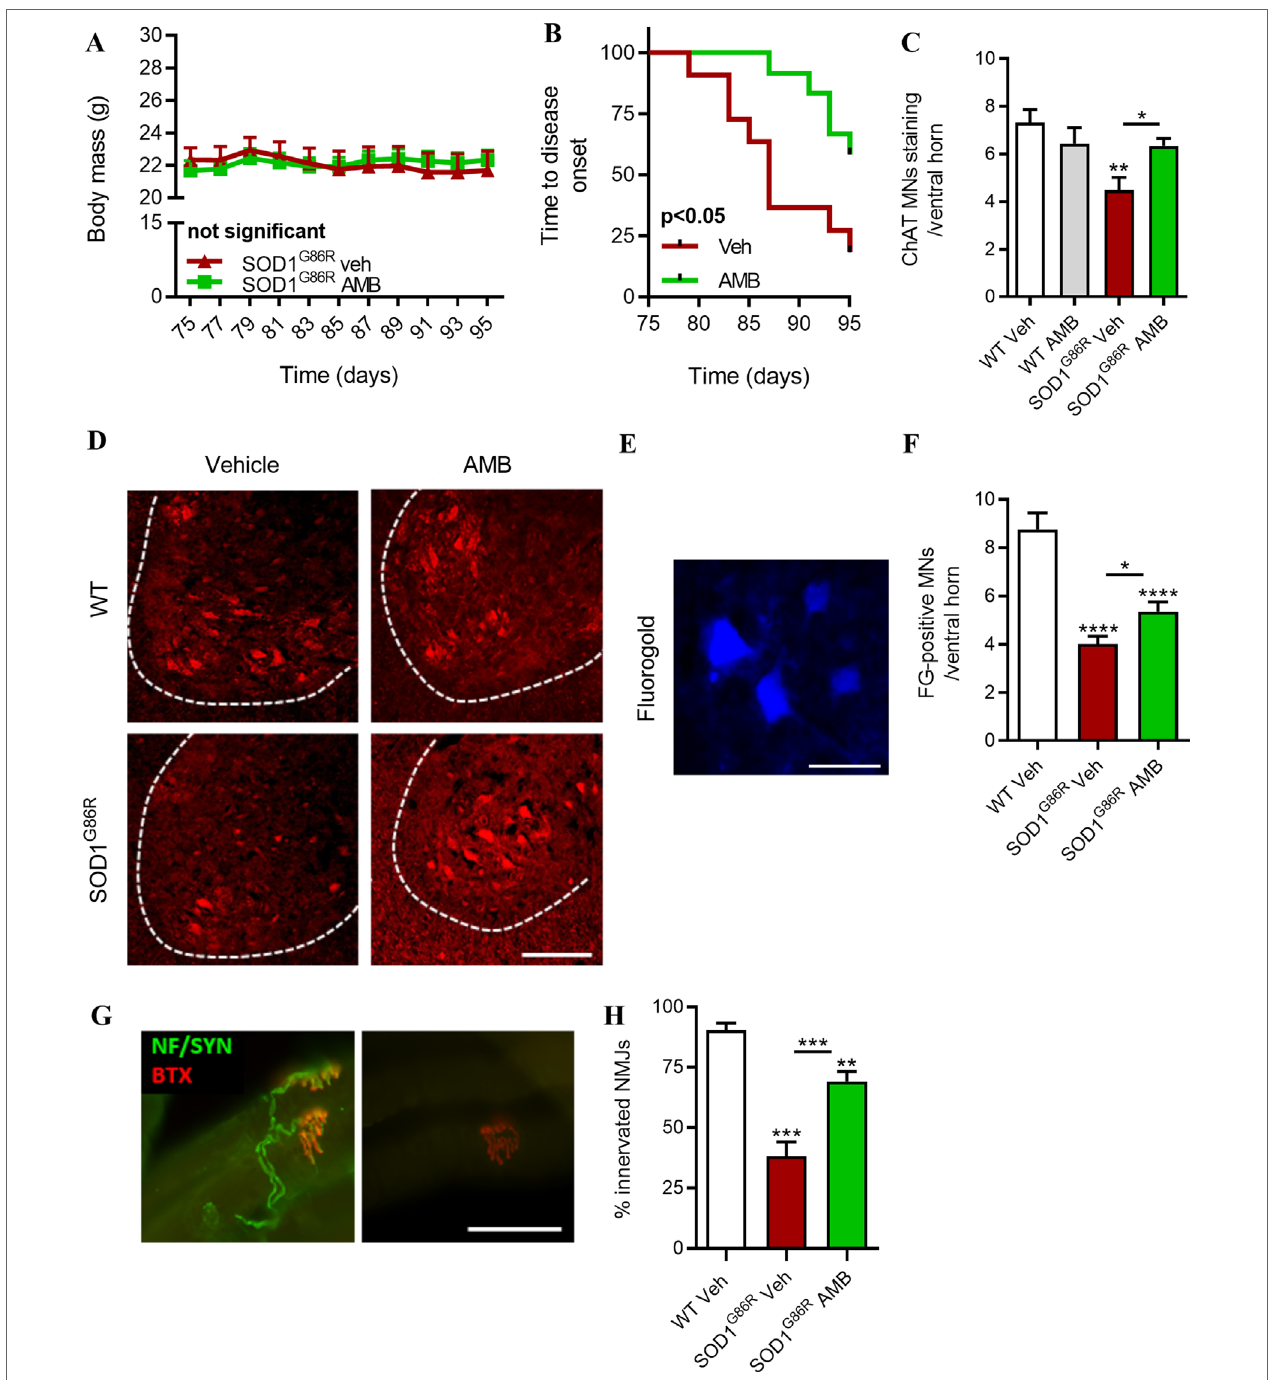
FIGURE 2 | AMB improves motor functions and preserves neuromuscular junction and the functional motor neurons (MNs) in pre-symptomatic SOD1 G86R mice. (A) Body mass evolution in SOD1 G86R mice after AMB treatment (not significant, n = 11–12/group). (B) Kaplan–Meier showing time to onset of muscle strength loss in SOD1 G86R mice ( p < 0.05, n = 11–12/group). (C) Quantification of choline acetyl transferase (ChAT)-positive cells located in the ventral horn of the spinal cord and having a size bigger than 400 μm 2 ( n = 5/group). (D) Representative pictures of the ventral horn of the L1–L3 lumbar area, after immunostaining with ChAT (red), a marker specific for spinal motor neurons. Ventral horns are delimited by dashed lines. Scale bar = 100 μm. (E) Representative picture of retrogradely labeled spinal MNs after fluorogold (FG) injection in hindlimb muscles. Scale bar = 50 µm. (F) Quantification of FG-positive MNs in ventral horn of the spinal cord ( n = 10/group, * p < 0.05; **** p < 0.00001, one-way ANOVA test). (G) Representative pictures of innervated (left panel) and denervated (right panel) of neuromuscular junctions in SOD1 G86R mice (bungarotoxin, BTX, red; neurofilament and synaptophysin, green). Scale bar = 50 μm. (H) Neuromuscular junctions (NMJ) integrity in tibialis anterior muscle (** p < 0.01; *** p <